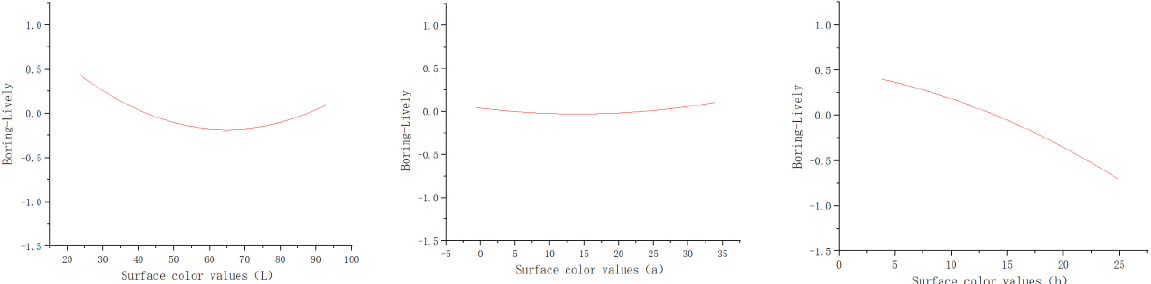
Figure 18. “Dull-Lively” and surface colour polynomial fitting function.